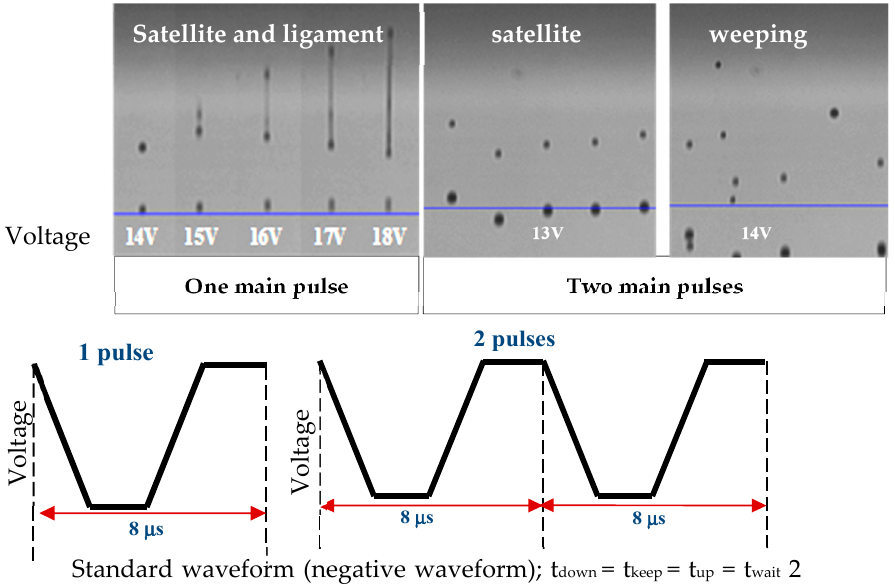
Figure 1. Droplet shape for edible ink using standard/basic waveform.